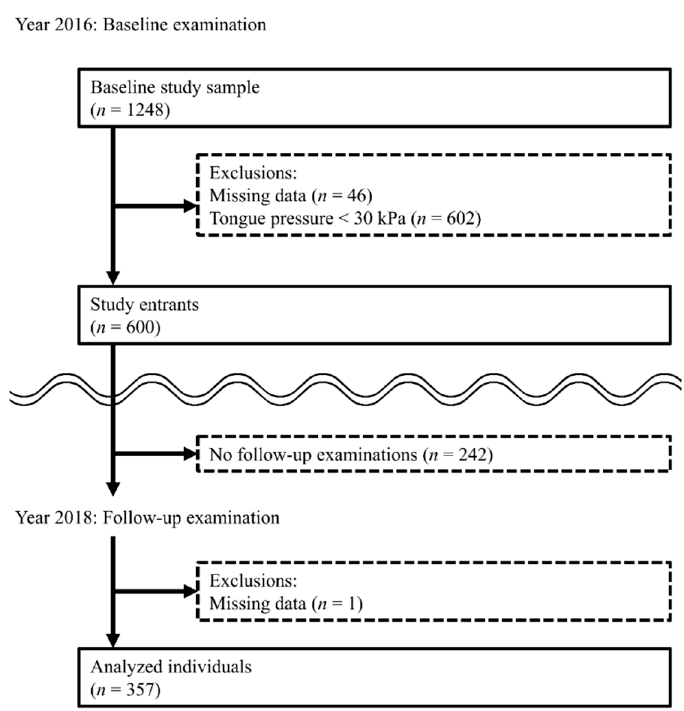
Figure 2. Flow diagram of our study.